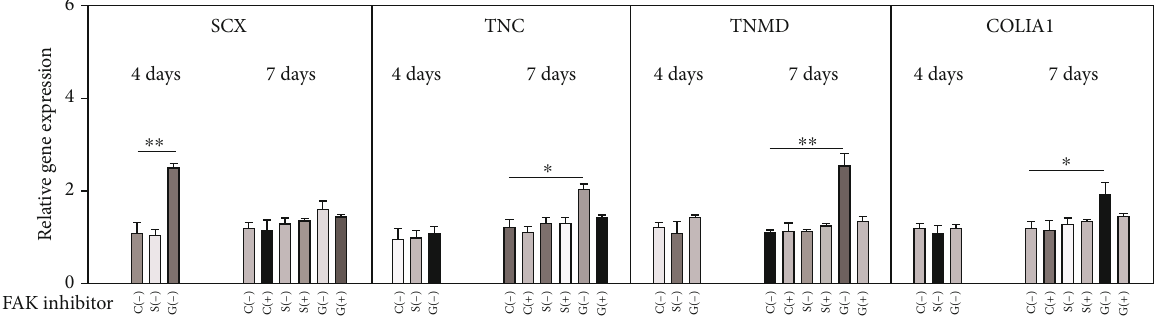
Figure 5: The relative mRNA expression of SCX, TNC, TNMD, and COLIA1 on days 4 and 7, with or without the FAK inhibitor. n = 3 , ∗ P < 0 : 05 , and ∗∗ P < 0 : 01 .